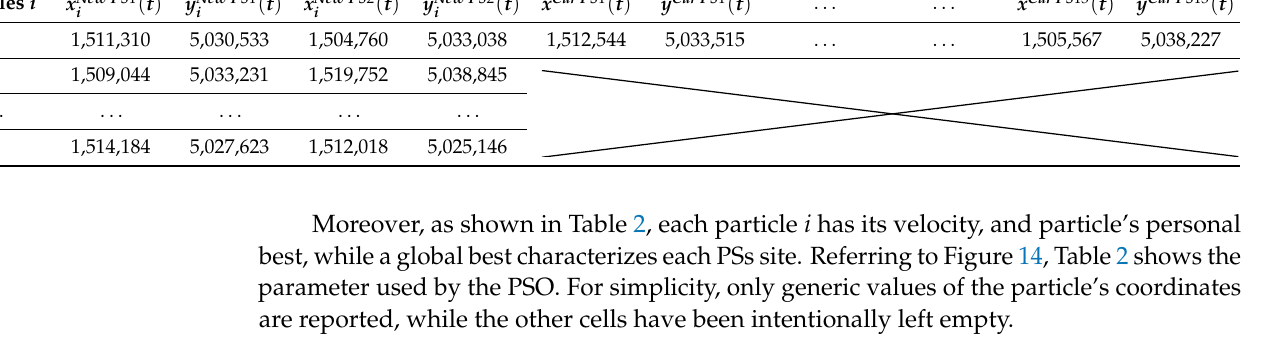
Table 1. Matrix of new and current PSs location. Figure 14. Example of siting two new PSs among several others already in place. New PSs are in red while existing ones are in purple. As depicted in Table 1, the PSO only modifies the location of the two new PSs, i.e., (𝑥 𝑖𝑁𝑒𝑤 𝑃𝑆1 (𝑡); 𝑦 𝑖𝑁𝑒𝑤 𝑃𝑆1 (𝑡)) and (𝑥 𝑖𝑁𝑒𝑤 𝑃𝑆2 (𝑡); 𝑦 𝑖𝑁𝑒𝑤 𝑃𝑆2 (𝑡)) , while the location of the current PSs are taken as they are, e.g., (𝑥 𝐶𝑢𝑟 𝑃𝑆1 (𝑡); 𝑦 𝐶𝑢𝑟 𝑃𝑆1 (𝑡)) .